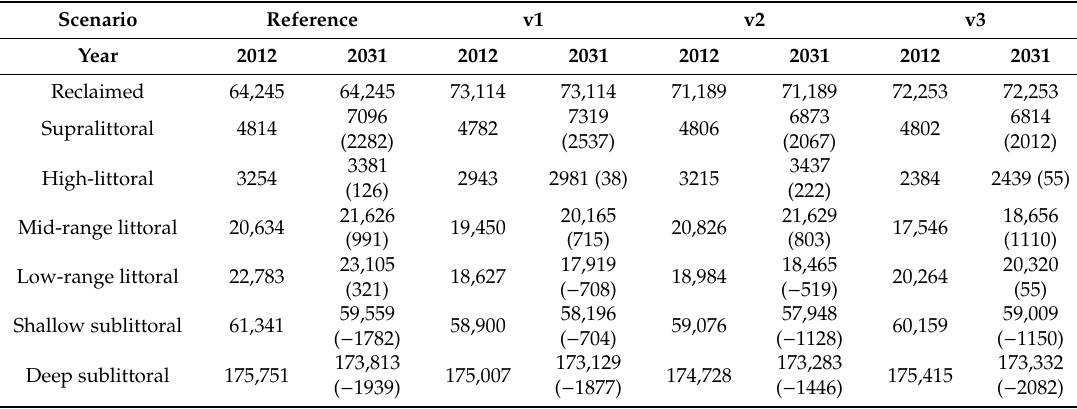
Table 1. Total ecotope area [ha] at the start (2012) and end (2031) of the simulation for the reference case and each configuration. The total net cumulative growth or decline during this period for each case is shown between